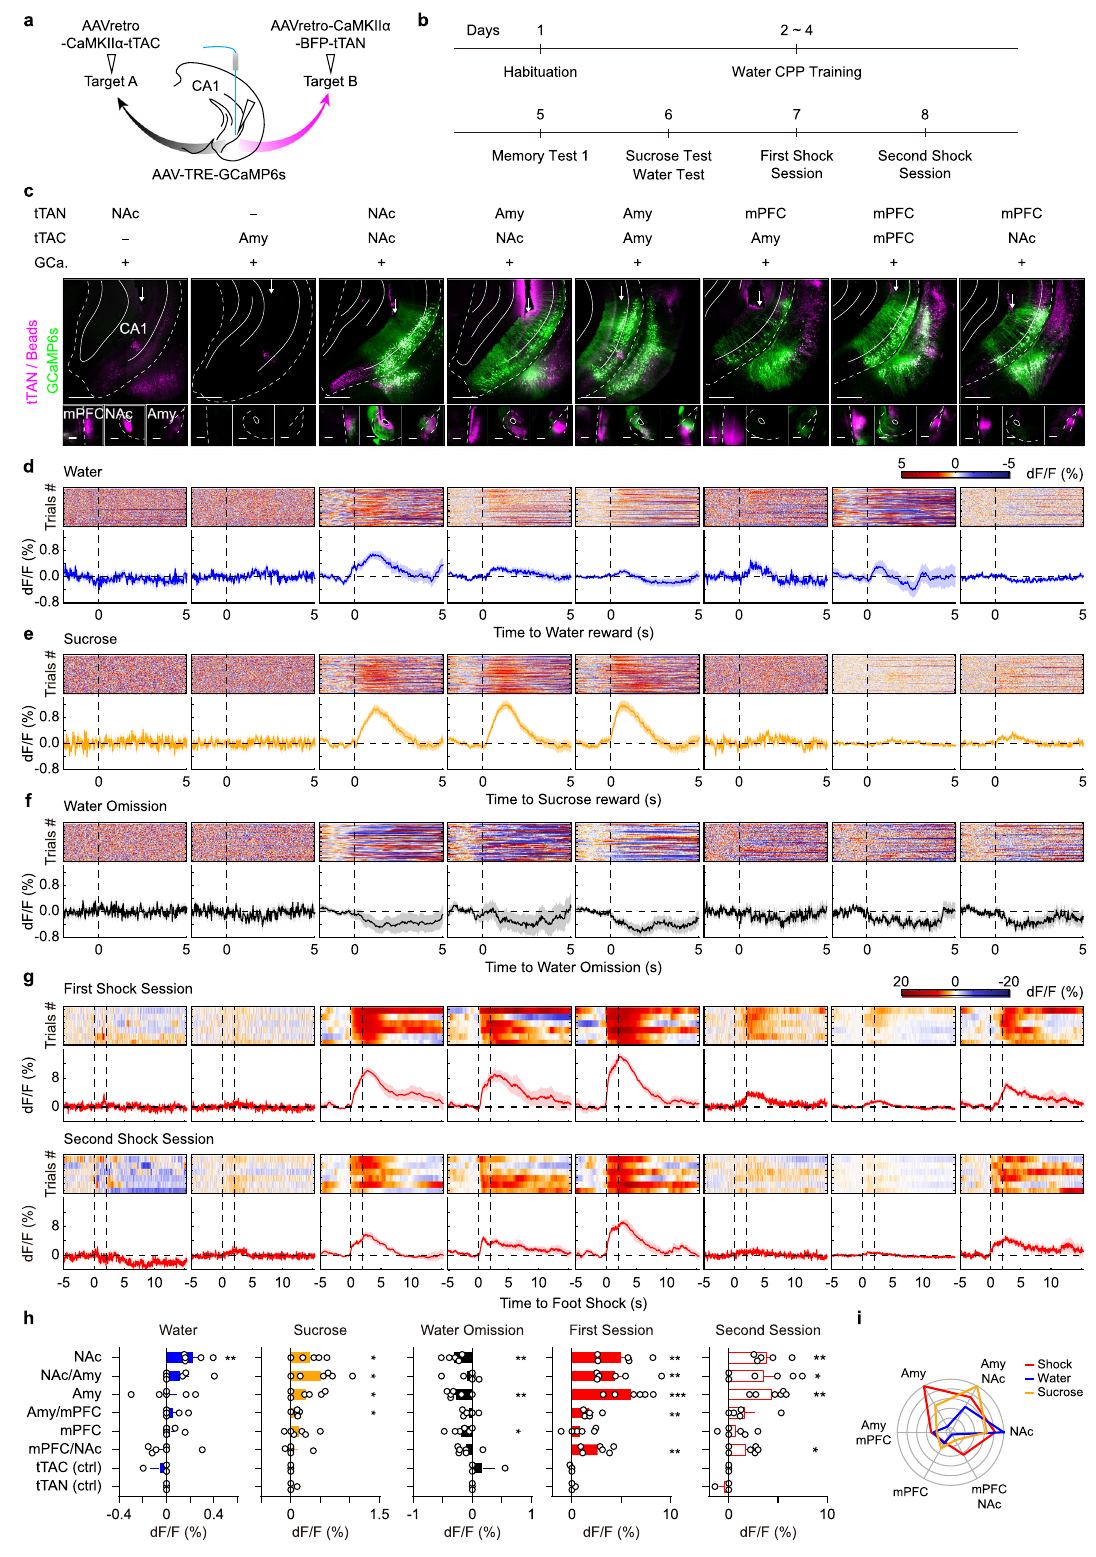
projecting and NAc-Amy-projecting vCA1 cells responded strongly and all types of vCA1 cells with mPFC connections responded weakly, if not none (Fig. 5h and i). Notably, water reward elicited speci fi c activations of NAc-projecting and NAc- Amy-projecting vCA1 cells. Interestingly, the omission of